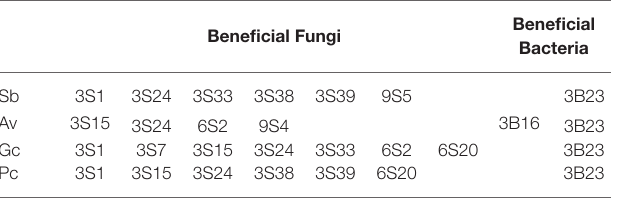
TABLE 2 | The recruited beneficial microbes by exogenous ectomycorrhizal fungi/dark septate endophyte